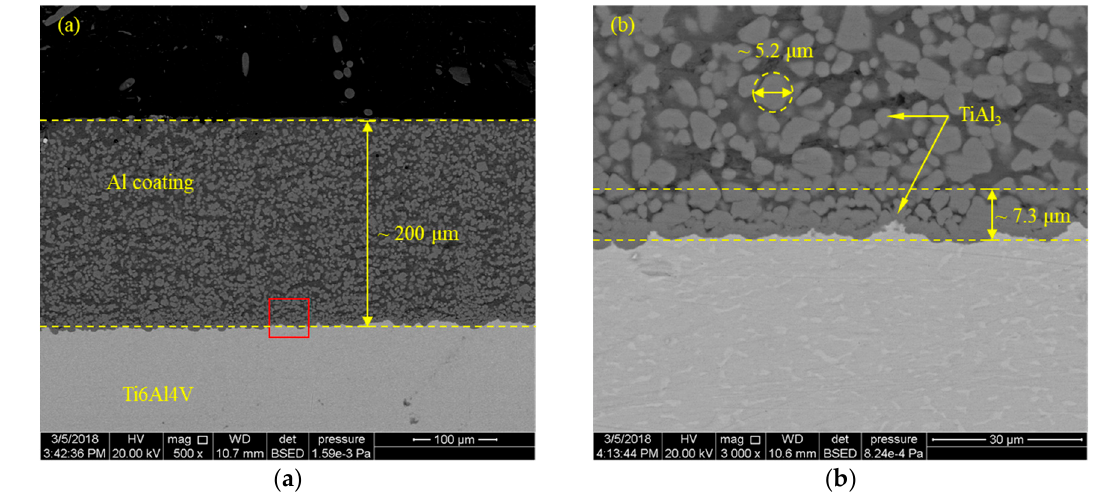
Figure 1. Cross-sectional morphology of the hot-dip aluminized Ti6Al4V alloy; ( a ) low magnification and ( b ) high magnification (red square marked in (a)).